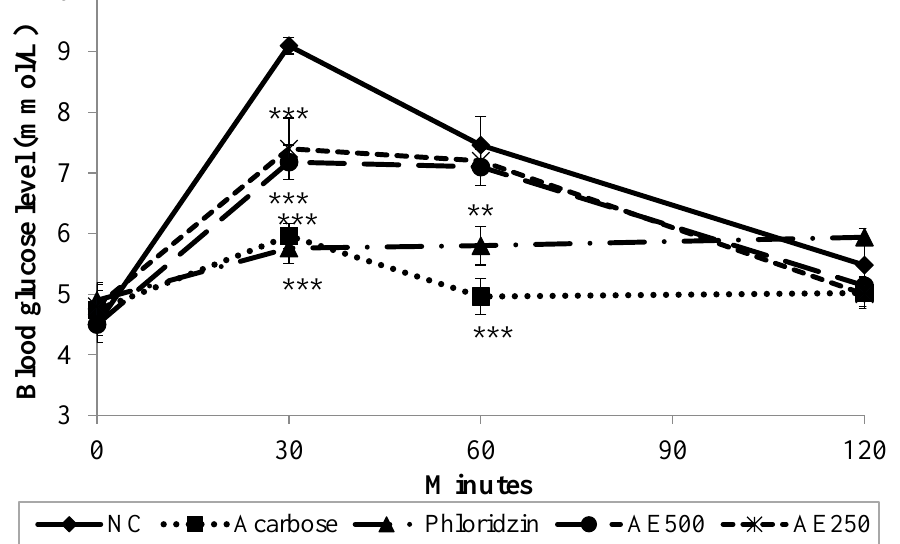
Figure 4. Effect of normal control (NC), acarbose, phloridzin and aqueous extract (AE) of NPV on postprandial glucose levels in oral starch tolerance test. Data is expressed as means ˘ S.E.M. ( n = 6). ** p < 0.01, and *** p < 0.001 vs. the NC